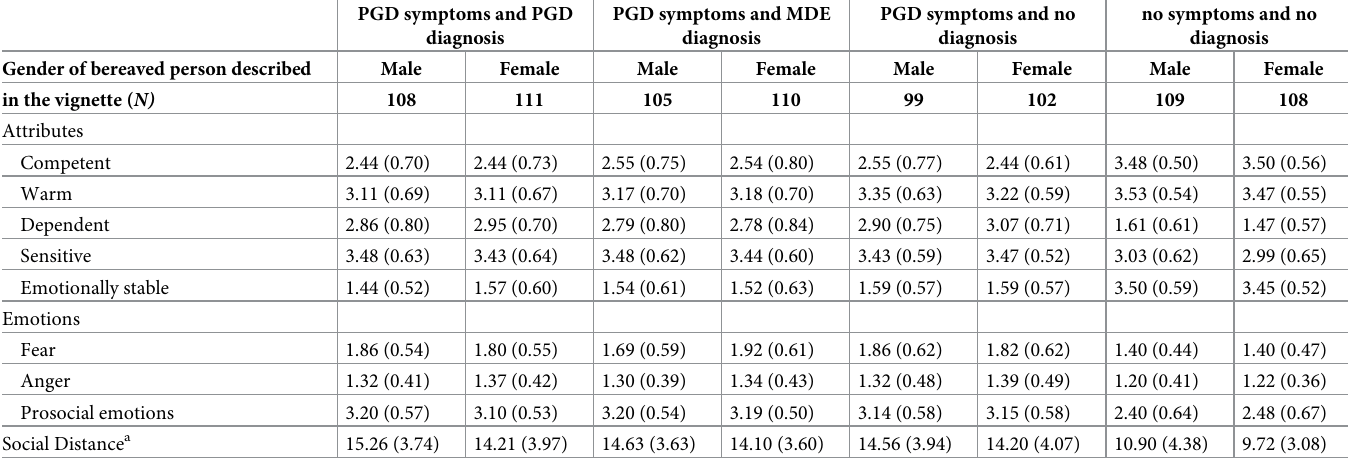
Table 3. Means and standard deviations of stigma outcomes per experimental